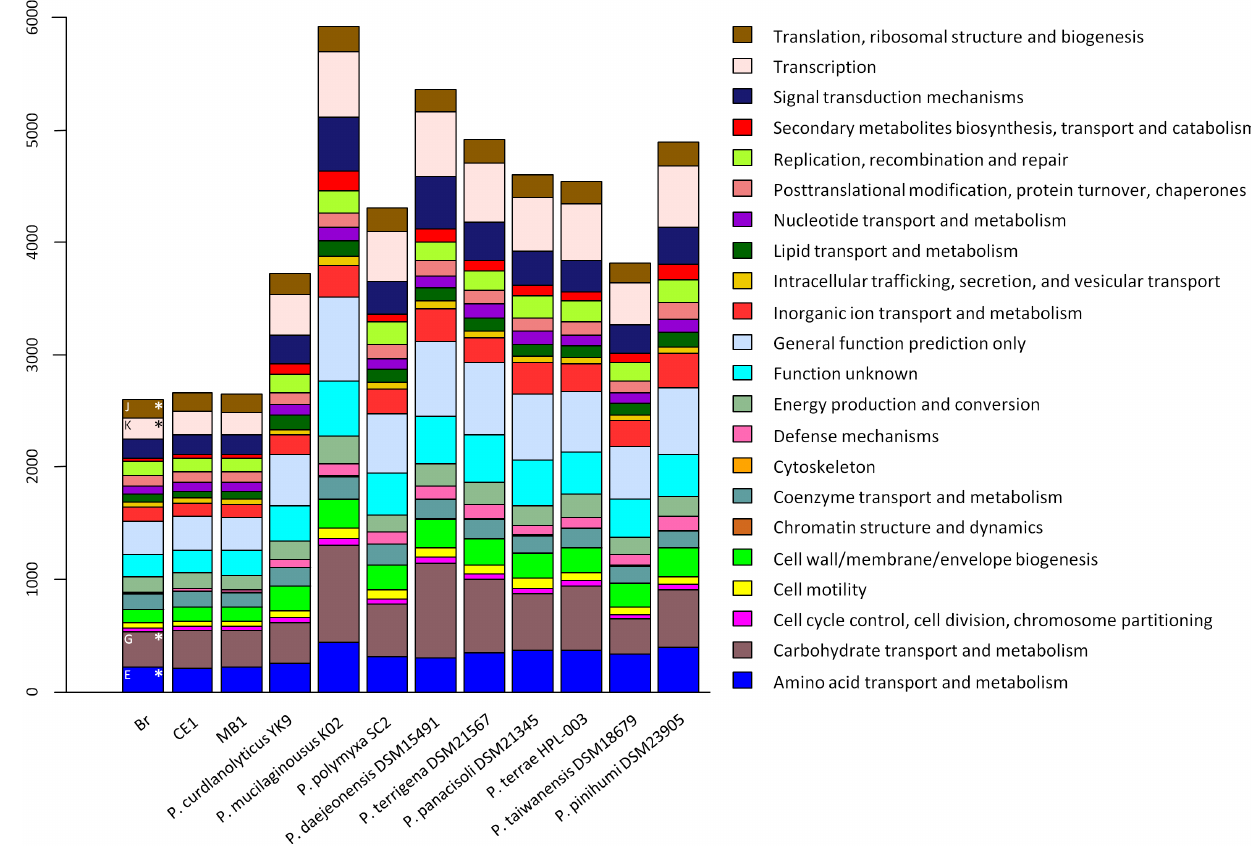
Figure 1. Comparison of gene content in temperate Paenibacillus spp. and P.darwinianus strains by COG categories.